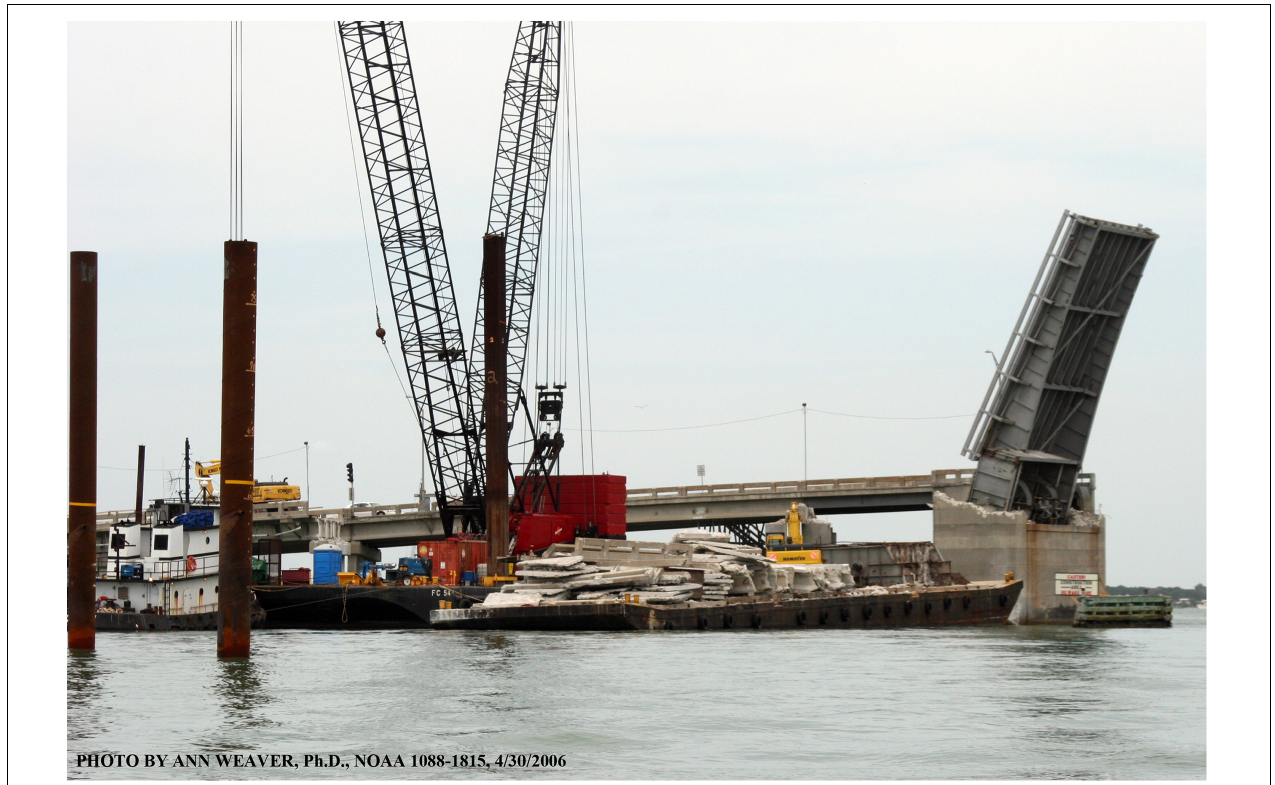
FIGURE 3 | The first set of impacts was mainly destruction and removal of above-water cement structures. Shown here is the partially dismantled NW lift tower housing before the bascule leaf and lift mechanisms were